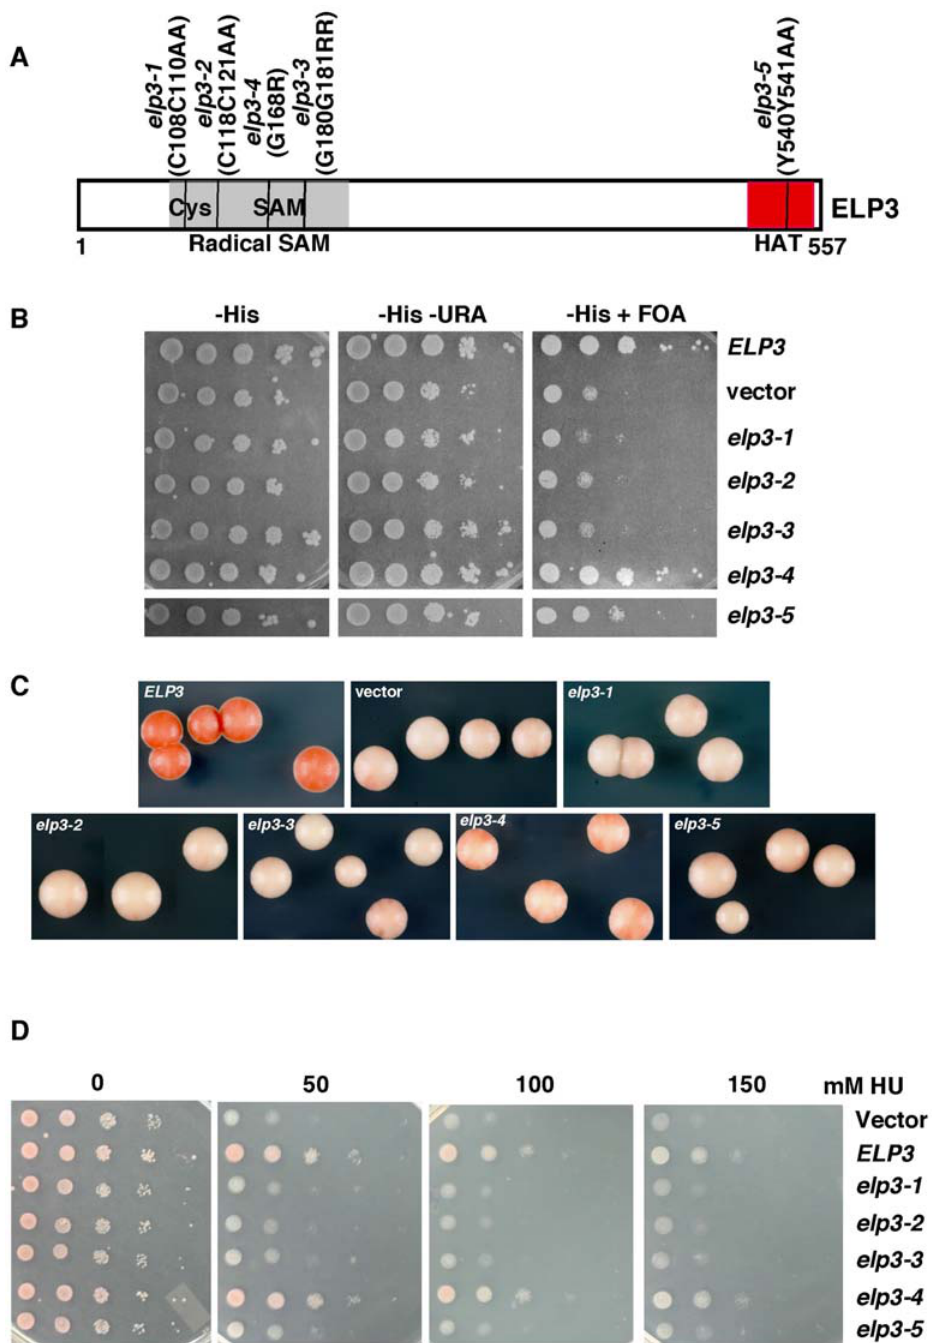
Figure 2. Cells expressing elp3 site-specific mutants with mutations at the HAT domain and the conserved Radical SAM domain of Elp3 reduce transcriptional silencing and are sensitive to HU. (A) A schematic representation of mutations on Elp3. Highlighted are the domains that bind S-adenosylmethionine (SAM) and the signature of histone acetyltransferase (HAT). Several amino acids located in the Radical SAM domains were mutated and these included elp3-1 with cysteine residues 108 and 110 replaced with alanine; elp3-2 with cysteine residues 118 and 121 replaced with alanine; elp3-4 with glycine 168 replaced with an arginine; elp3-3 with glycine 180 and 181 replaced with arginine. Two tyrosine residues Tyr 540 and 541 located at HAT domain were also replaced with alanine ( elp3-5 ). (B) Four of the five site-specific elp3 D mutants reduce telomeric silencing. Plasmids expressing wild type or each of the elp3 mutants were transformed into the elp3 D mutant cells and telomeric silencing was assayed as described in Figure 1. (C) All five elp3 mutants reduce silencing of the ADE2 gene at telomeres. The ADE2 gene was integrated at the HMR locus and used to assay silencing of each of the five site-specific elp3 D mutants. (D) The site-specific elp3 mutant cells are also sensitive to HU. Ten fold serial dilutions of yeast cells expressing wild type or each of the five site-specific elp3 mutants were spotted onto different concentrations of HU media as indicated.